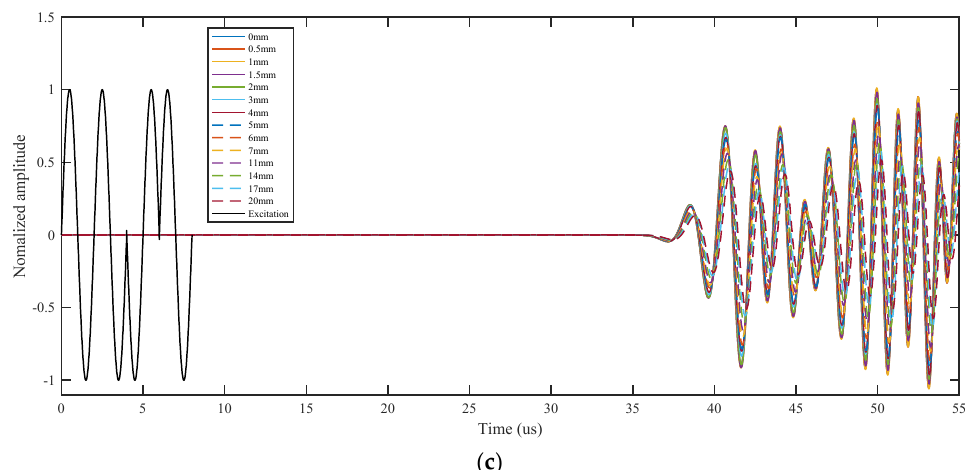
Figure 8. FE simulation of Lamb wave response with different crack lengths: ( a ) L-Chip signal; ( b ) A wave of GCC signal; ( c ) B-wave of GCC signal.